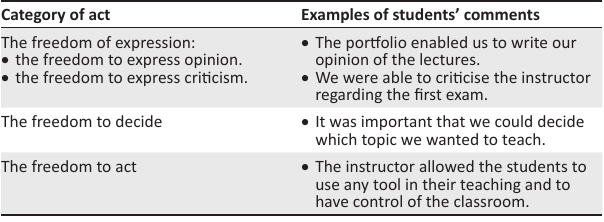
TABLE 1 : Pedagogic acts promoting freedom.